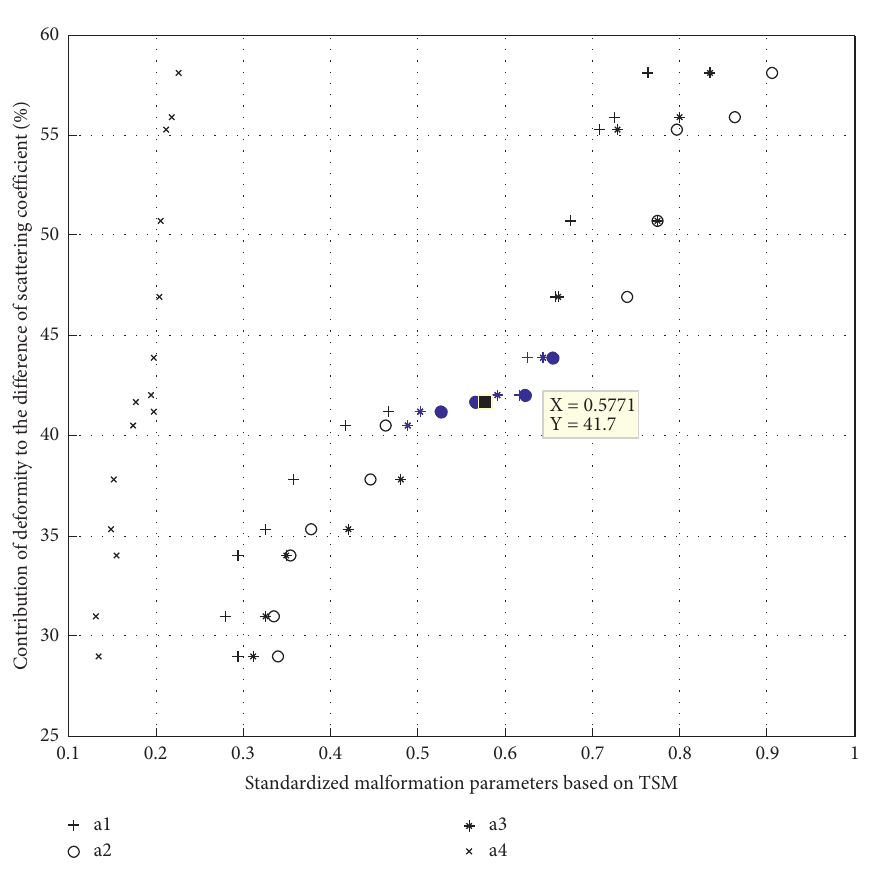
Figure 11: Contribution of normalized deformation to the difference of scattering